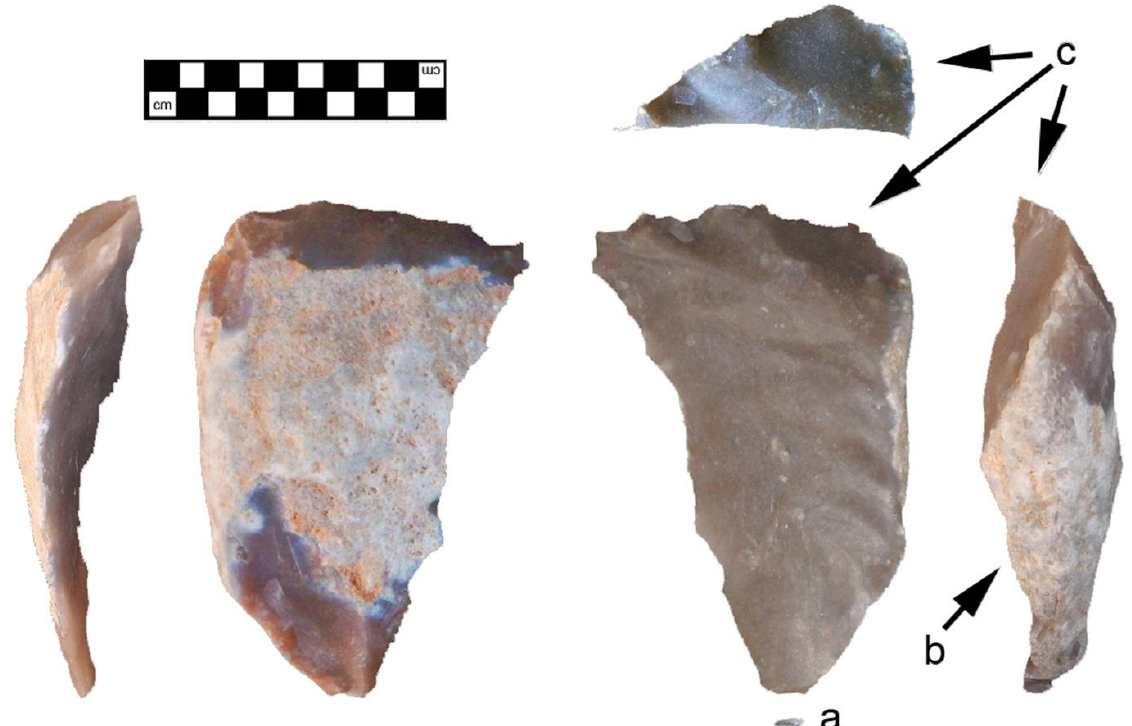
Figure 4. Replica 2 Flake 1 overshot flake. A) platform; b) large basal removal; c) removed